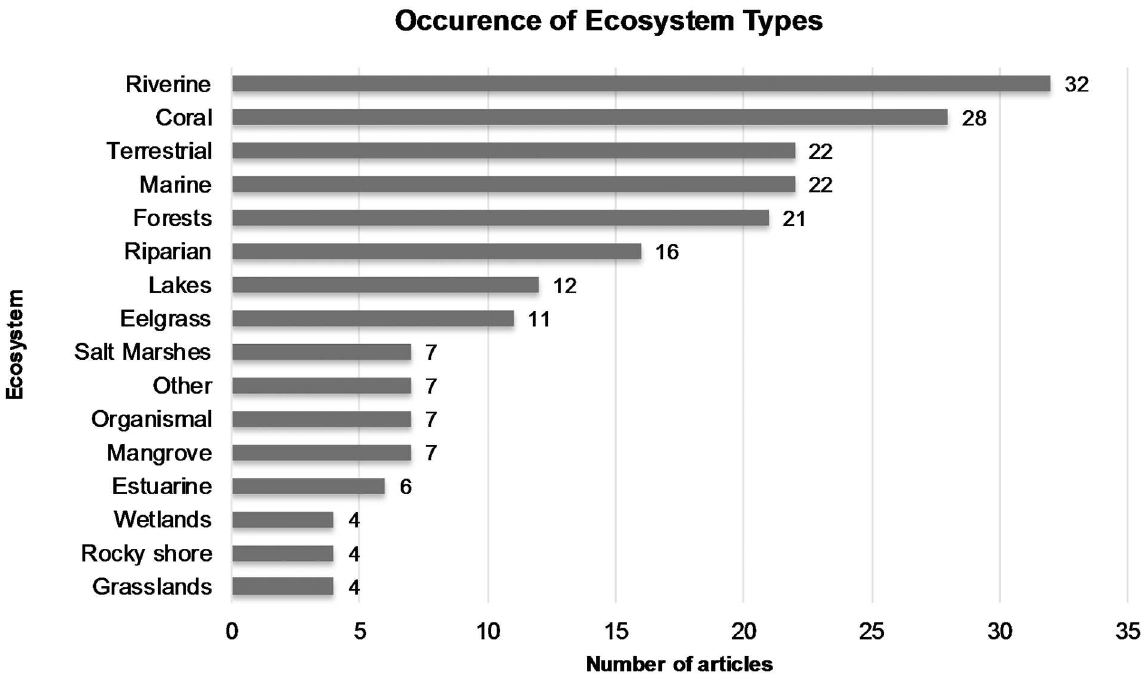
Fig 1. Frequency distribution of articles by